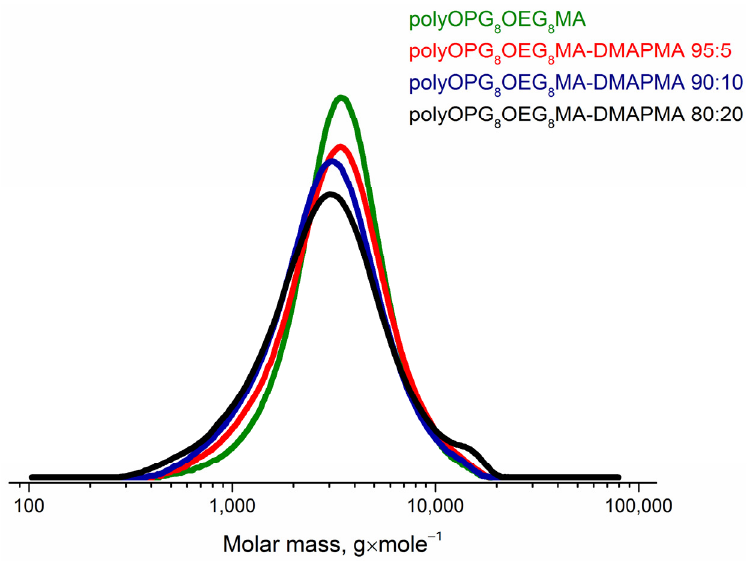
Figure 3. GPC traces of the polymers.